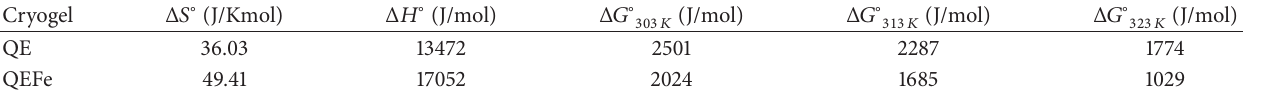
Table 3: Thermodynamic parameters.